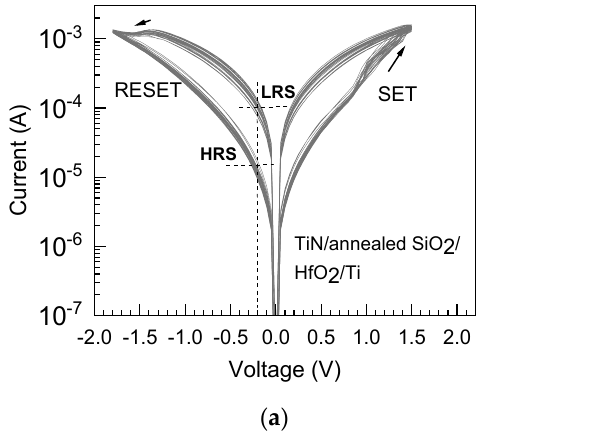
Figure 7. Current–voltage ( a ) and endurance ( b ) characteristics measured in a resistive switching regime on the TiN/SiO 2 /HfO 2 /Ti cell structure built on the TiN/SiO 2 base stack annealed at 1000 °C (Sample 4 in Table 1). The low- and high-resistivity states, denoted by LRS and HRS, respectively, were recorded at reading voltages of 0.2 V.